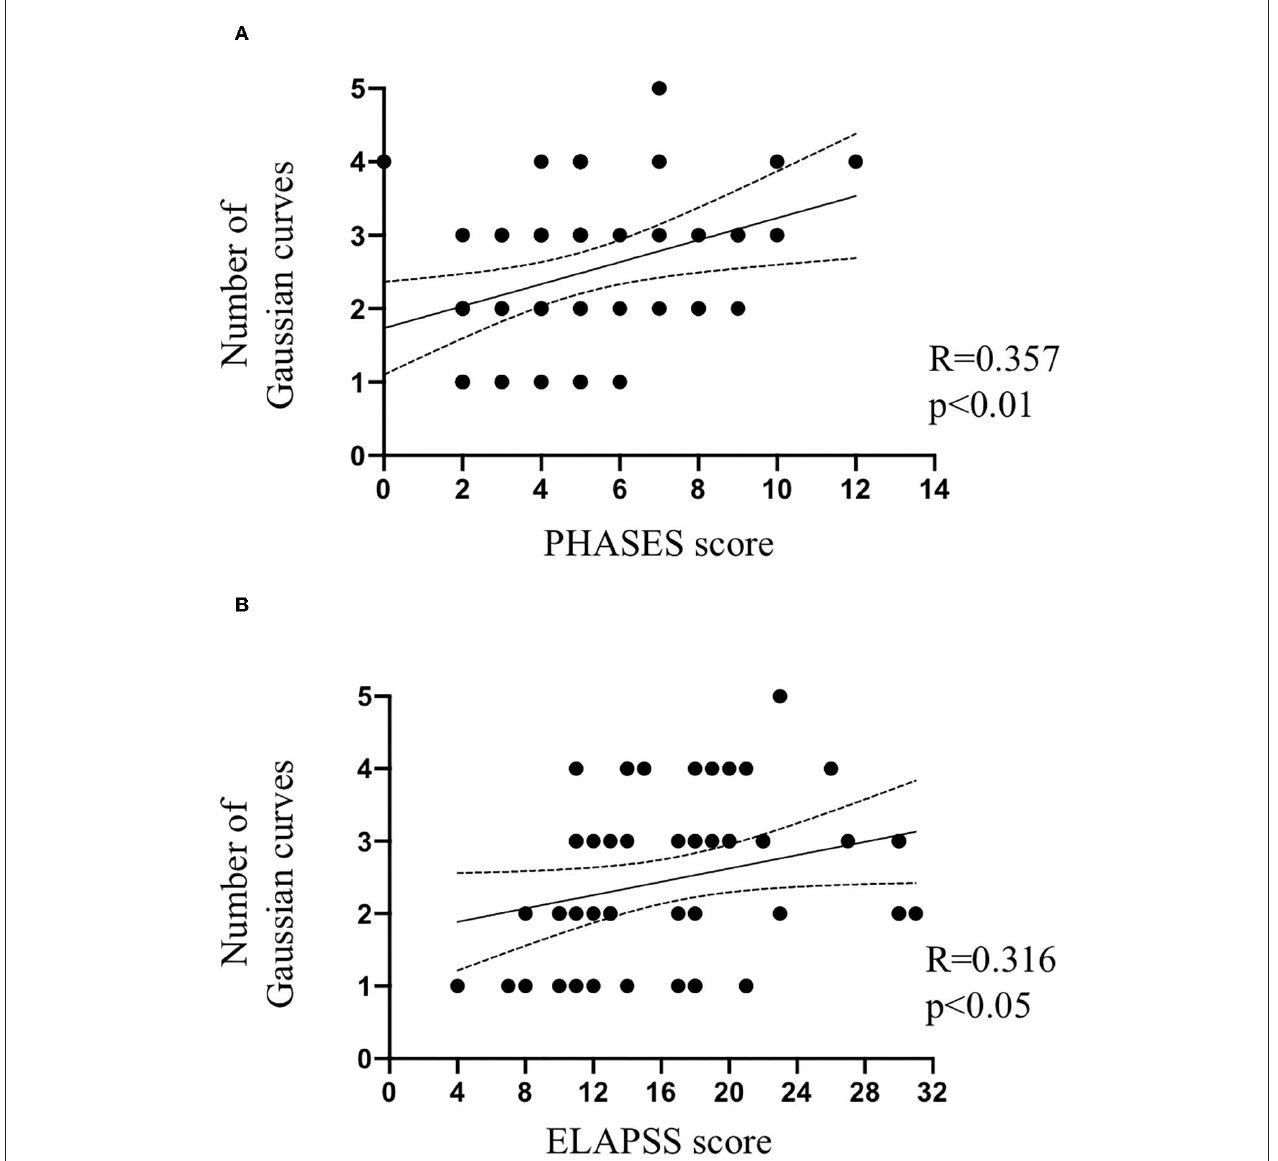
FIGURE 7 | IA wall uniformity and clinical scores. Spearman correlations between PHASES score (A) or ELAPSS score (B) and the number of Gaussian curves characterizing IA wall